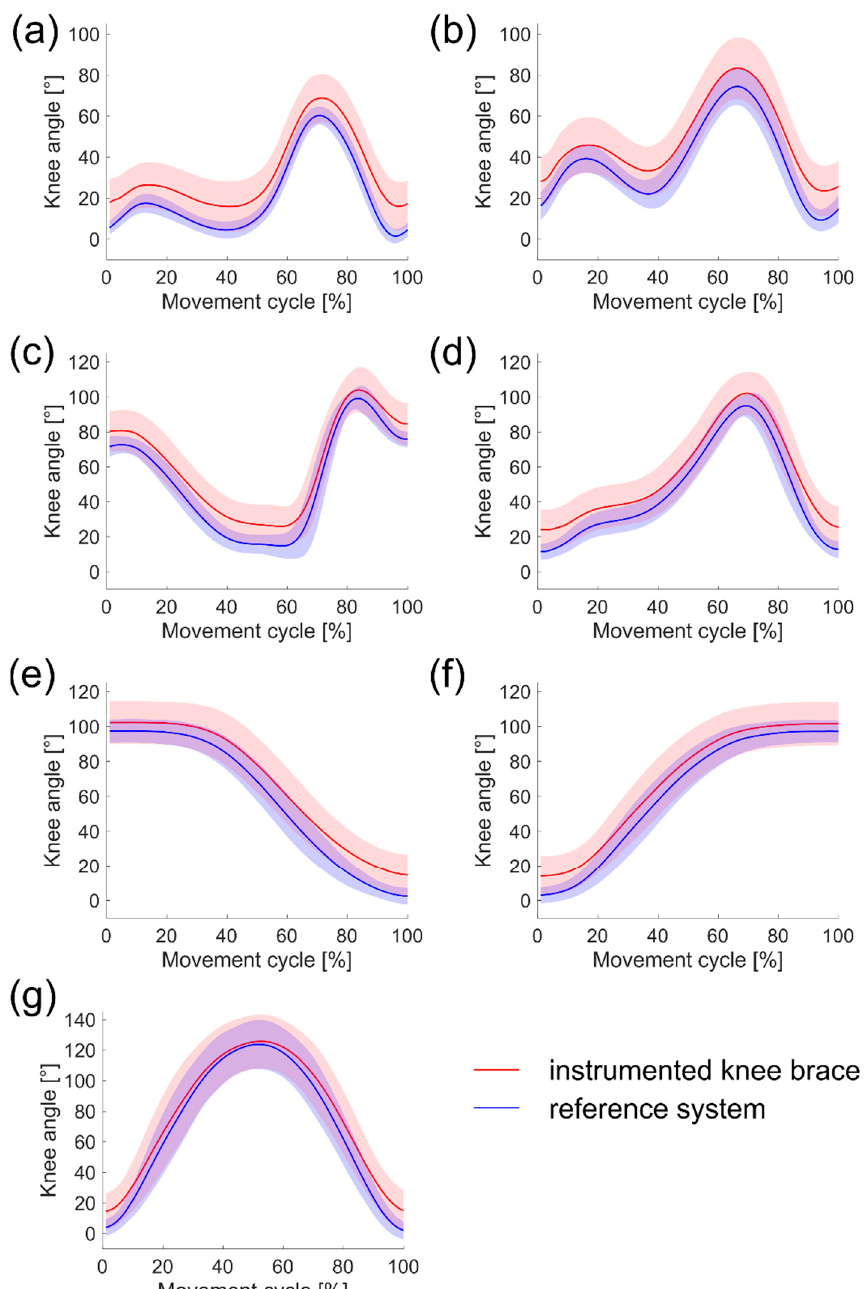
Figure 4. Knee angle outputs of session 1 for ( a ) walking, ( b ) jogging, ( c ) stair ascent, ( d ) stair descent, ( e ) chair rise, ( f ) sitting down, and ( g ) squatting; the red line and corresponding shaded area represent the mean knee angle and standard deviation measured by the instrumented knee brace, the blue line and corresponding shaded area represent the mean knee angle and standard deviation measured by the reference system.